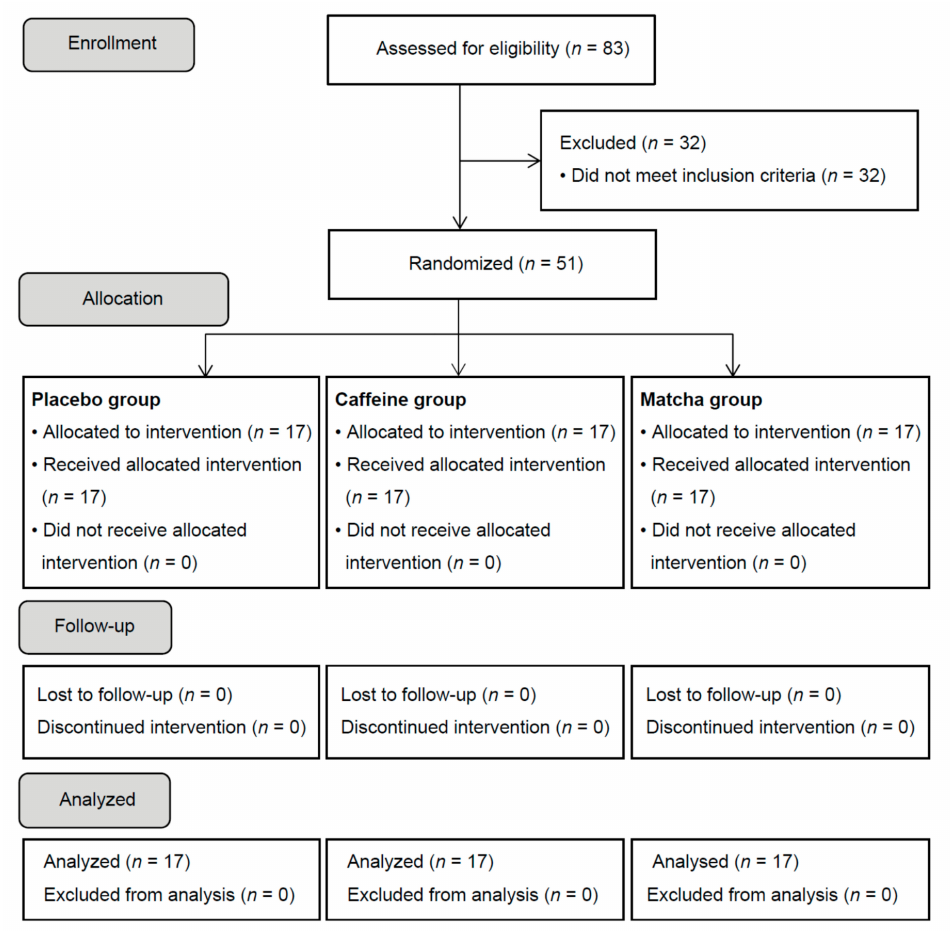
Figure 1. Study flow